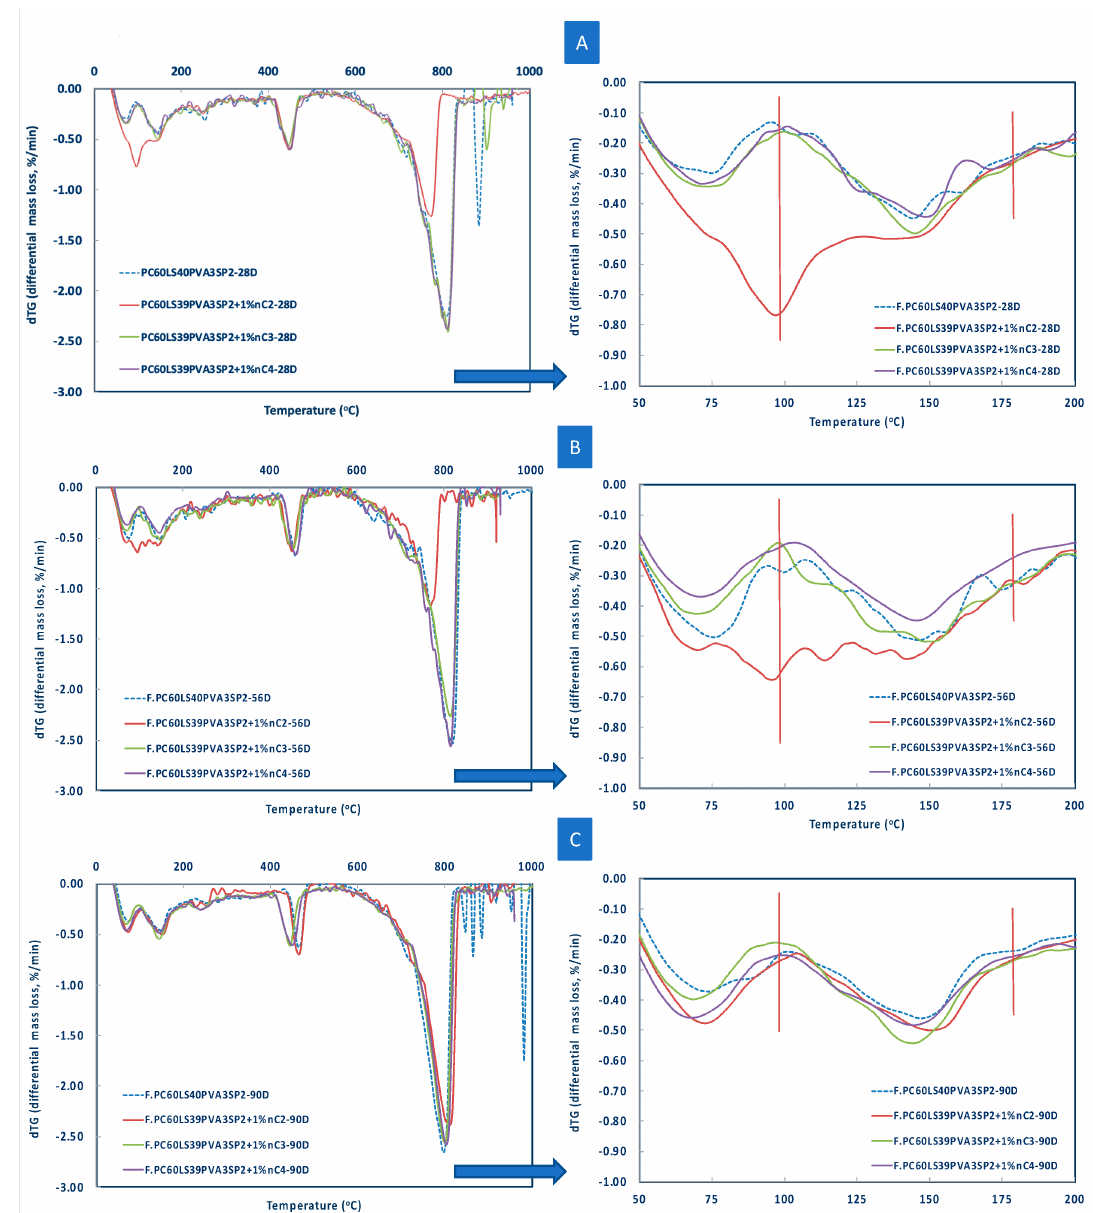
Figure 9. Di ff erential mass loss of fiber–cement nanohybrids based on F.PC60LS40PVA3SP2 between 100–200 ◦ C at ( A ) day 28, ( B ) day 56, and ( C ) day